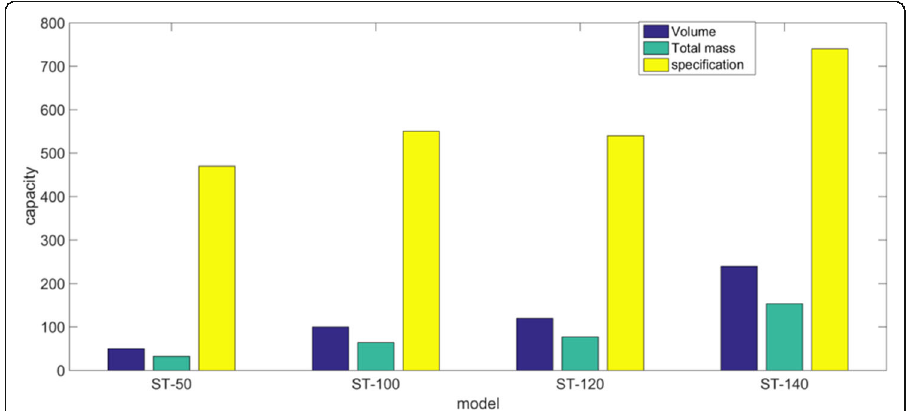
Fig. 4 Specific models and specifications of trash bins with different volumes